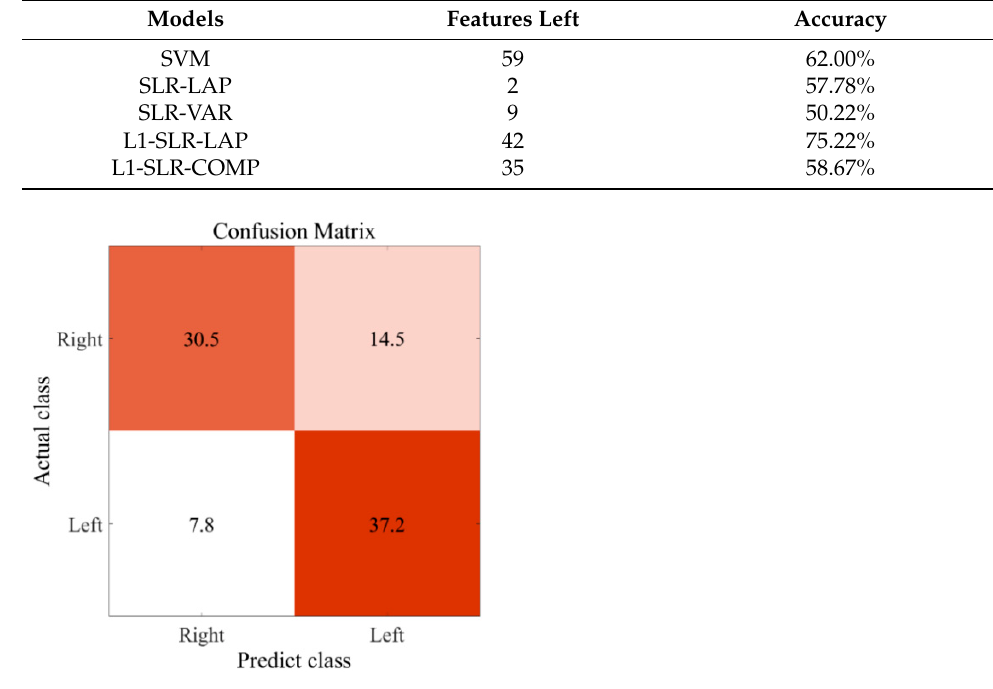
Table 5. Accuracy of different classifiers used on our EEG data. Models